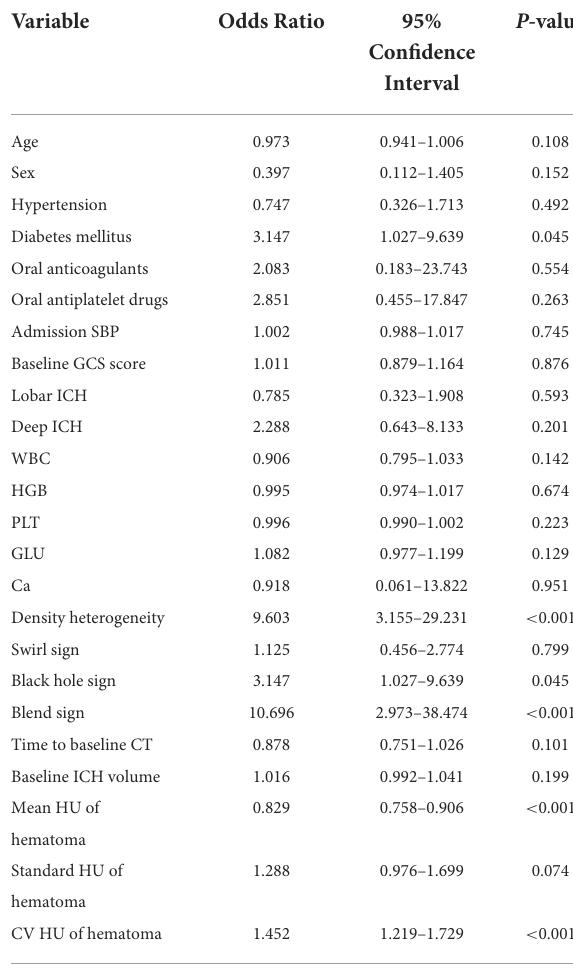
TABLE 2 Univariate analysis of predictors for early hematoma